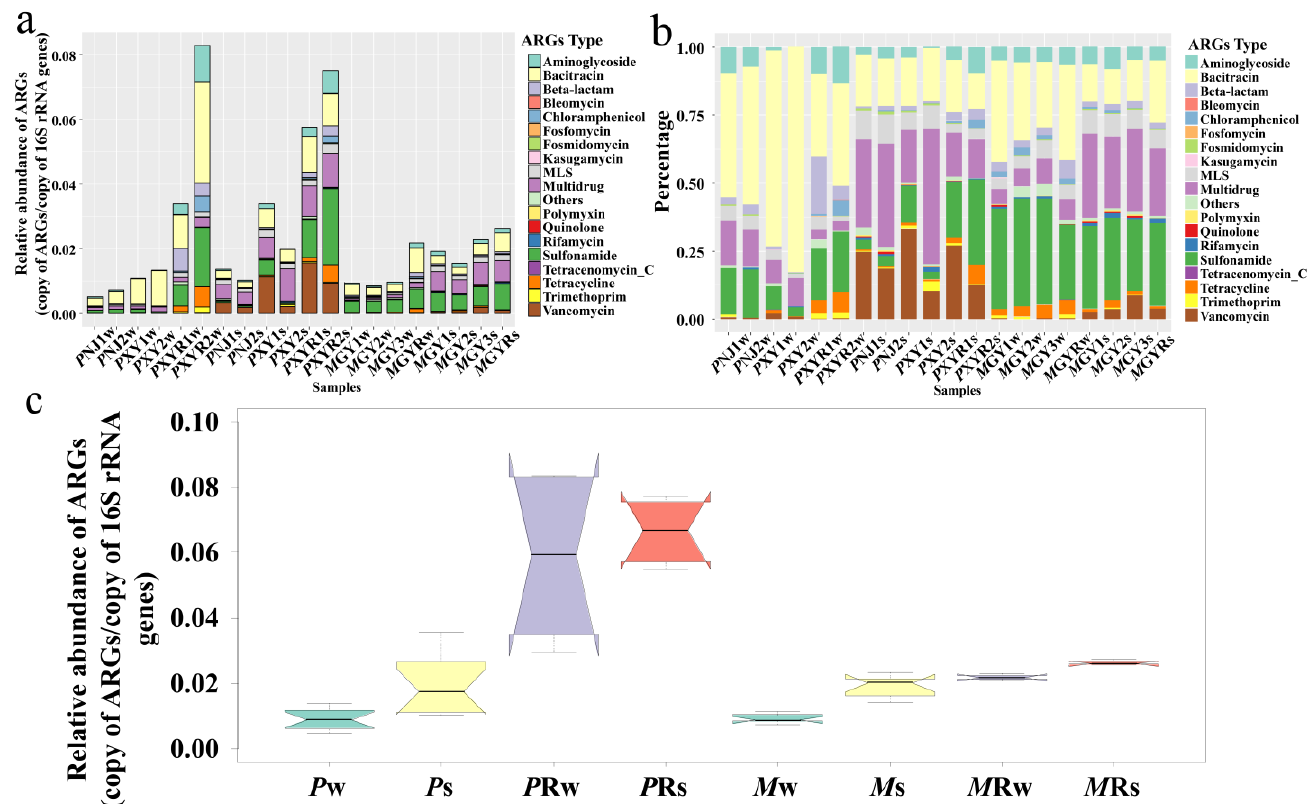
Figure 1. ( a ) Relative abundance of ARG types (copy of ARGs/copy of 16S rRNA genes). ARG types more than 10 − 6 copy of ARGs/copy of 16S rRNA genes are listed, while the rest are regarded as ‘others’. ( b ) Percentages of different ARG types. ( c ) Relative abundance of ARGs detected from water/sediment in two types of shrimp ponds/corresponding downstream rivers (copy of ARGs/copy of 16S rRNA genes). The box-plot presents the biological replicates of all samples and the notch the 95% confidence intervals of the median.